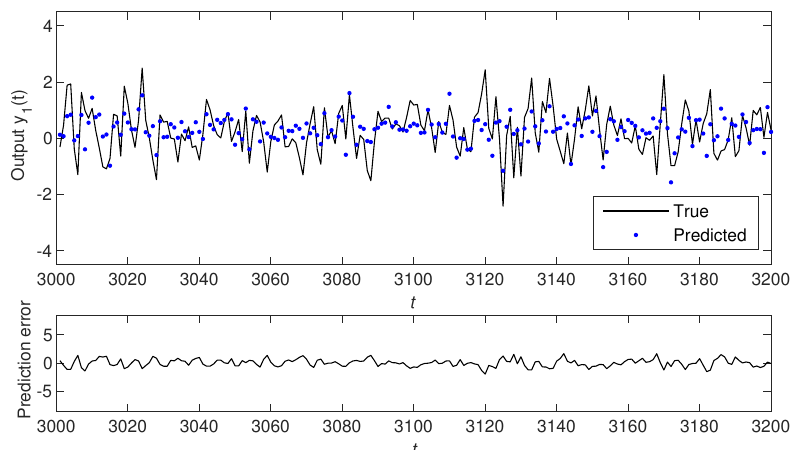
Figure 6. The true output, the predicted output of y 1 ( t ) and the prediction error.